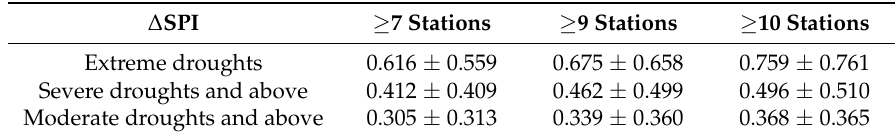
Table 5. The difference between two processing schemes ( ΔSPI ) for monitoring regional droughts of different levels varying with number of stations.